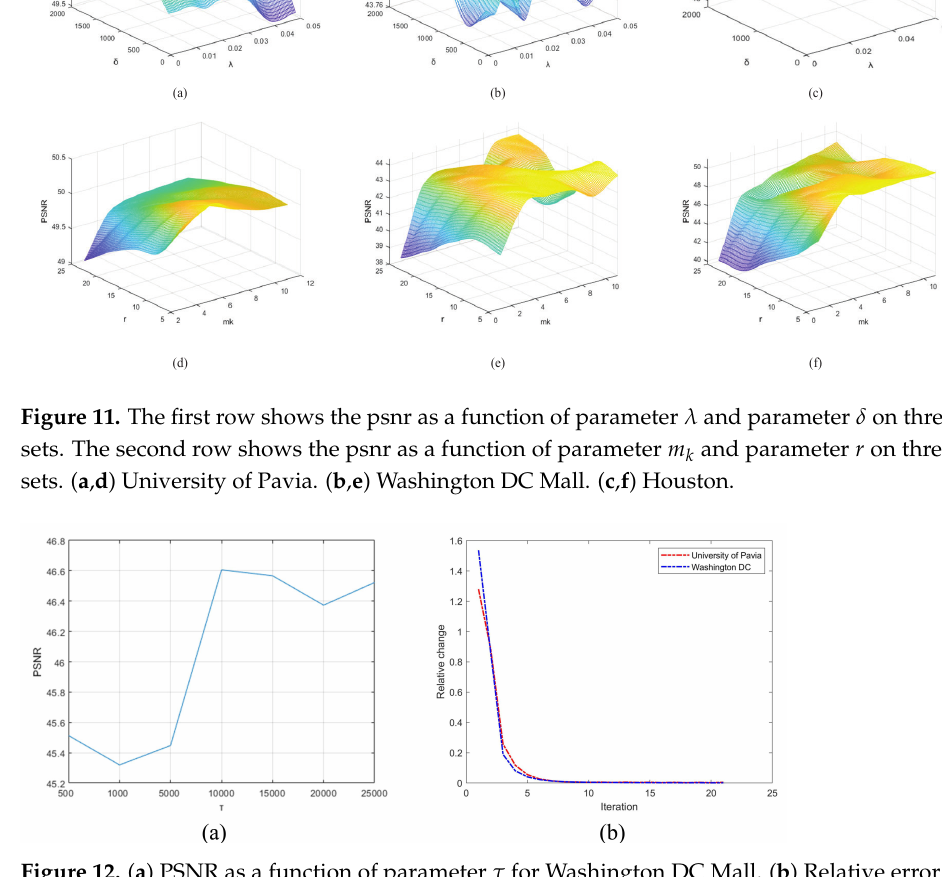
Figure 12. ( a ) PSNR as a function of parameter τ for Washington DC Mall. ( b ) Relative error of the reconstructed image for successive iterations for PU and